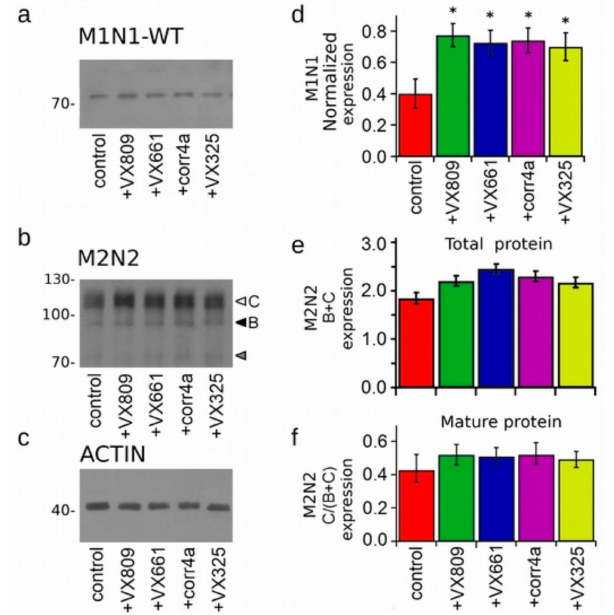
Figure 4. Expression of the WT-CFTR N-half co-expressed with the C-half. ( a ) Detection of WT-M1N1 in whole cell extracts of HEK-t cells co-transfected with WT-M1N1 + M2N2 and treated with DMSO (control) or with 5 µ M VX809, 5 µ M VX661, 10 µ M corr4a and 5 µ M VX325. ( b ) The M3A7